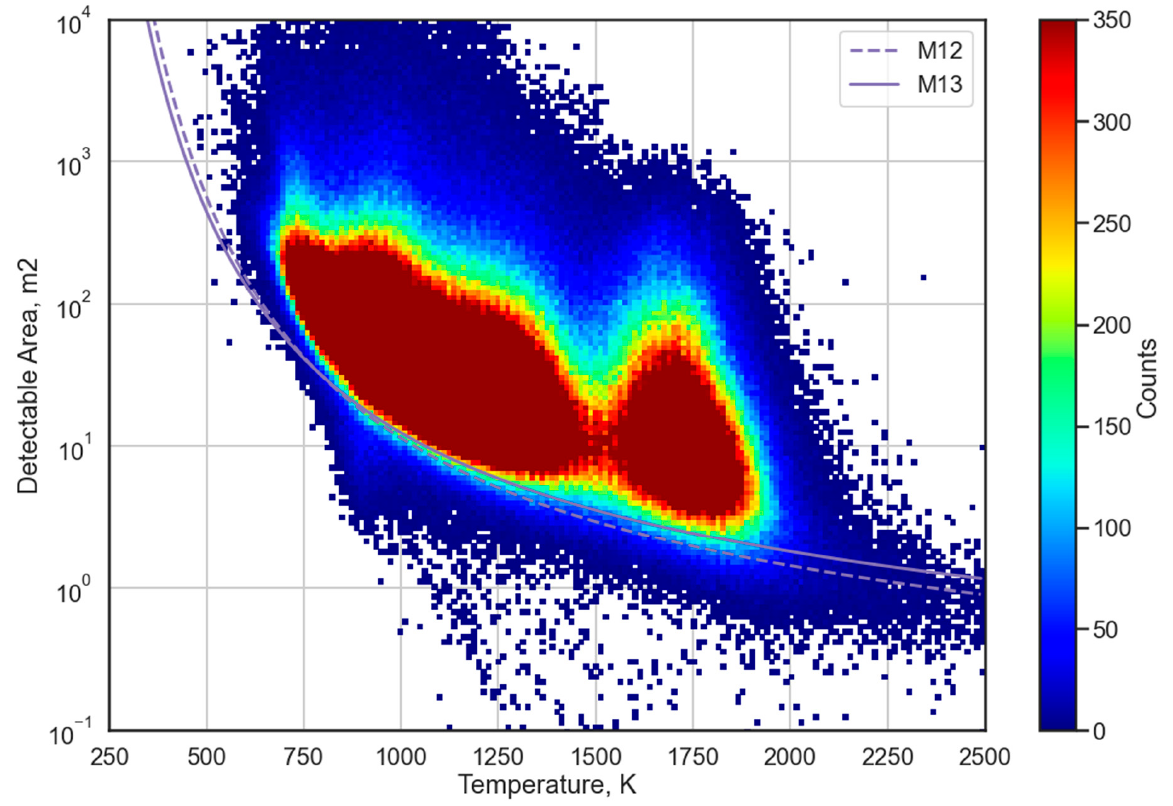
Figure 8. Scattergram of the temperature versus source area for VNF pixels with detection in M12– M13 spectral bands from entirety of 2018 with the detection limit lines.